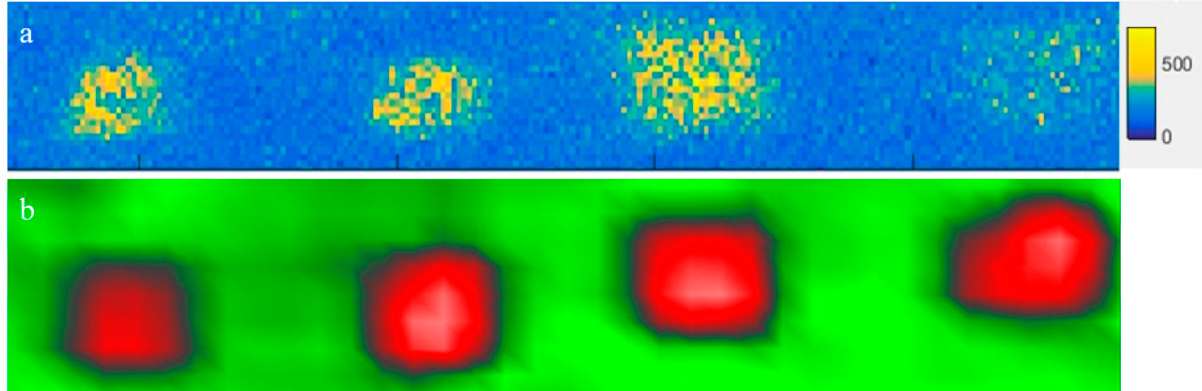
Figure 16. Noisy mode of robotic imaging of 4 square inserts in CFRP plate: AE imaging ( a ), wideband laser vibrometry ( b ).